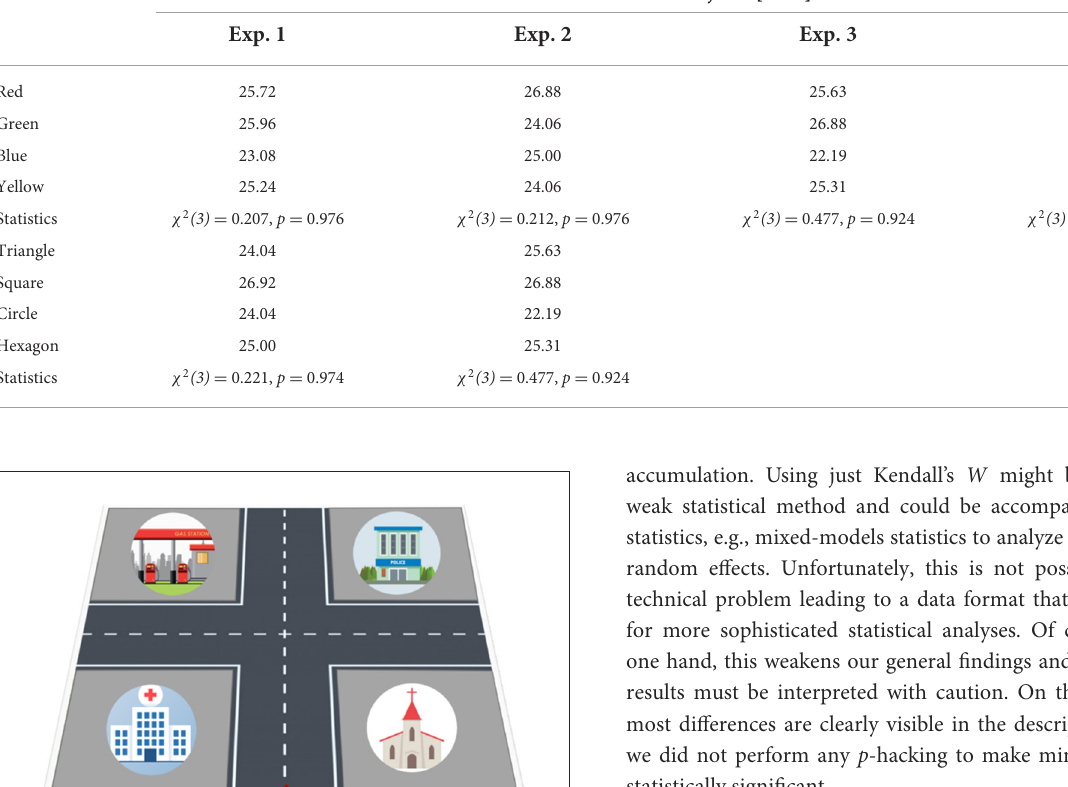
TABLE 1 Distribution of the visual object properties in all experiments.